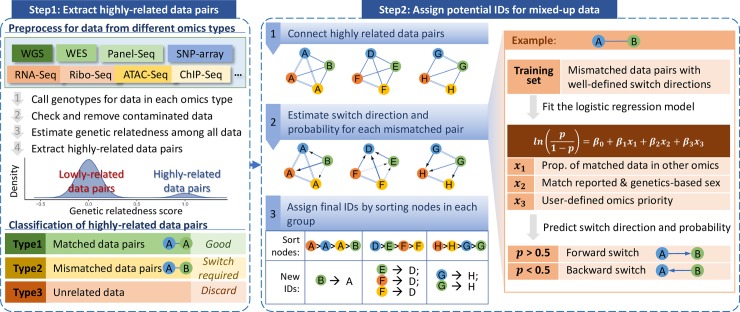
Illustration of key steps.The workflow has two steps: 1) extracting highly related data pairs; and 2) assigning potential data IDs. For the first step, genotypes were called for data from each omics types using GATK HaplotypeCaller. Contaminated data were checked and removed based on the VerifyBamID software and heterozygous rates. DRAMS then estimated genetic relatedness among all available omics data by comparing genotypes using GCTA. Any omics type that contains genetic information can be used here to call genotypes and compare genetic relatedness. Normally, the genetic relatedness scores for all data pairs were in bimodal distribution. Highly related data pairs were extracted based on the distribution of relatedness scores and connected to create multiple groups. Based on the matching of data IDs in each highly related data pair, we can classify the highly-related data pairs as “matched data pairs” and “mismatched data pairs”. We may also find some data unrelated to any other data. For the second step, we visualized the groups into multiple independent sub networks. For each sub network, each node represents a data in the group and each edge represents a highly-related data pair. The text in each node represents the data ID. Different colors represent different omics types. The parallel line connects matched data; whereas, the singular line connects mismatched data. After applying a logistic regression model, DRAMS tool estimated switch directions and probabilities for each mismatched data pair. The arrow denotes possible switch direction. The thickness of the line weight correlates to the degree of switch probability. The final IDs for the data in each group can be determined by sorting the nodes.